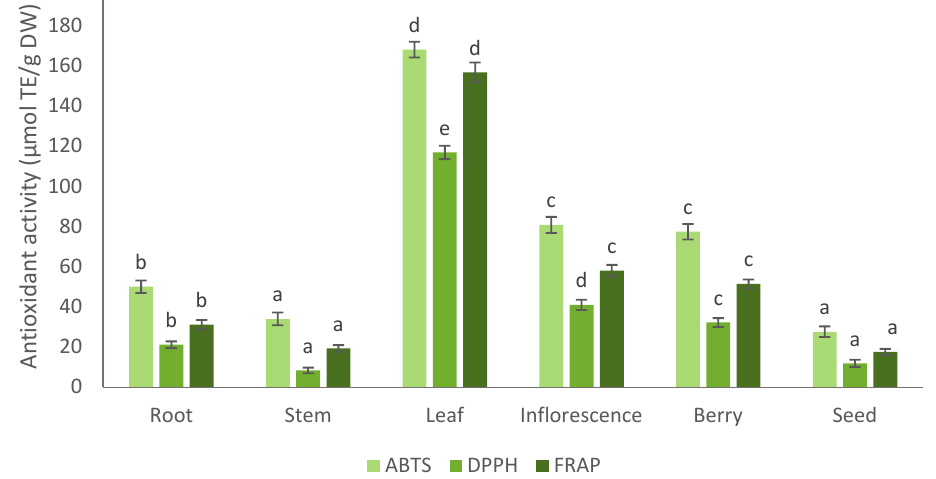
Figure 2. The antioxidant activity of A. cordata different morphological parts evaluated by using ABTS, DPPH, FRAP assays. Values were expressed as mean ± standard deviation ( n = 3); different letters indicate statistically significant differences between plant parts (one-way ANOVA and Tukey’s HSD test, p < 0.05).